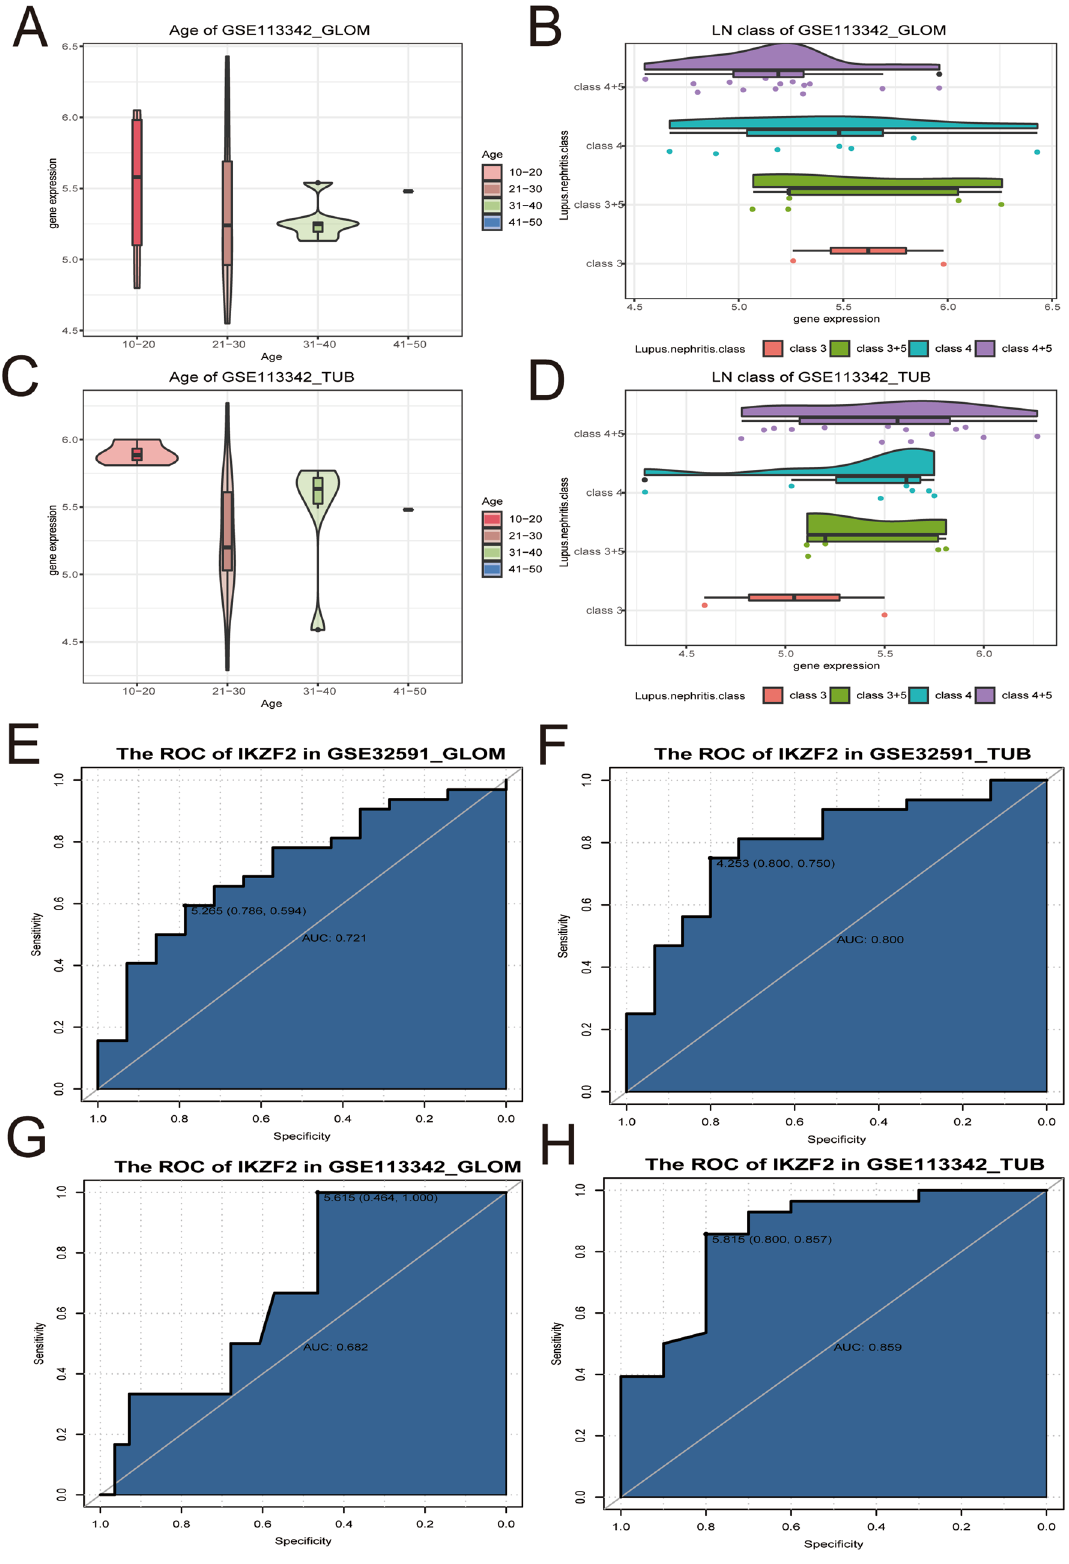
Figure 8. Clinical characteristics correlation analysis and relative risk assessment. ( A \ C ) Correlation analysis between the expression level of IKZF2 and the age of LN patients. The x-axis represented the age of LN patients, and y-axis denoted the expression of IKZF2 in the GLOM and TUB group from GES11342 dataset. Different color represented distinct group of age. ( B \ D ) Correlation analysis between the expression level of IKZF2 and the lupus nephritis class. The x-axis represented the expression of IKZF2 in the GLOM and TUB group from GES11342 dataset, and y-axis represented the disease grade of lupus nephritis, which included class3, class3 + 5, class4 and class4 + 5. ( E )–( H ) ROC curve of IKZF2 expression level to distinguish LN samples and LD in the four sets of data. The results showed that IKZF2 revealed a good AUC value in GSE32591_GLOM, GSE32591_TUB and GSE113342_TUB